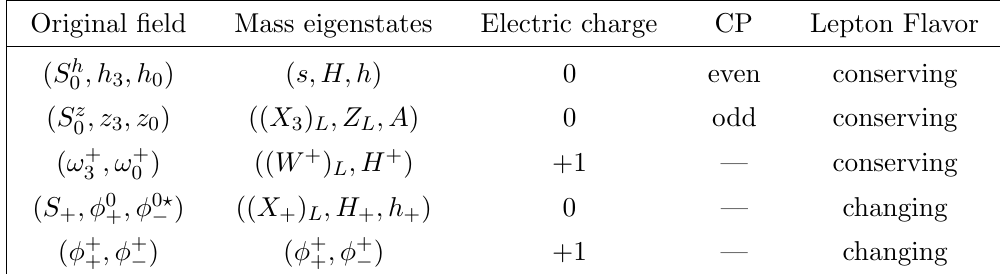
Table 2 . Properties of di(cid:11)erent sets of scalar (cid:12)elds in the model. The subscript L in the mass eigenstates denotes the longitudinal mode of the corresponding